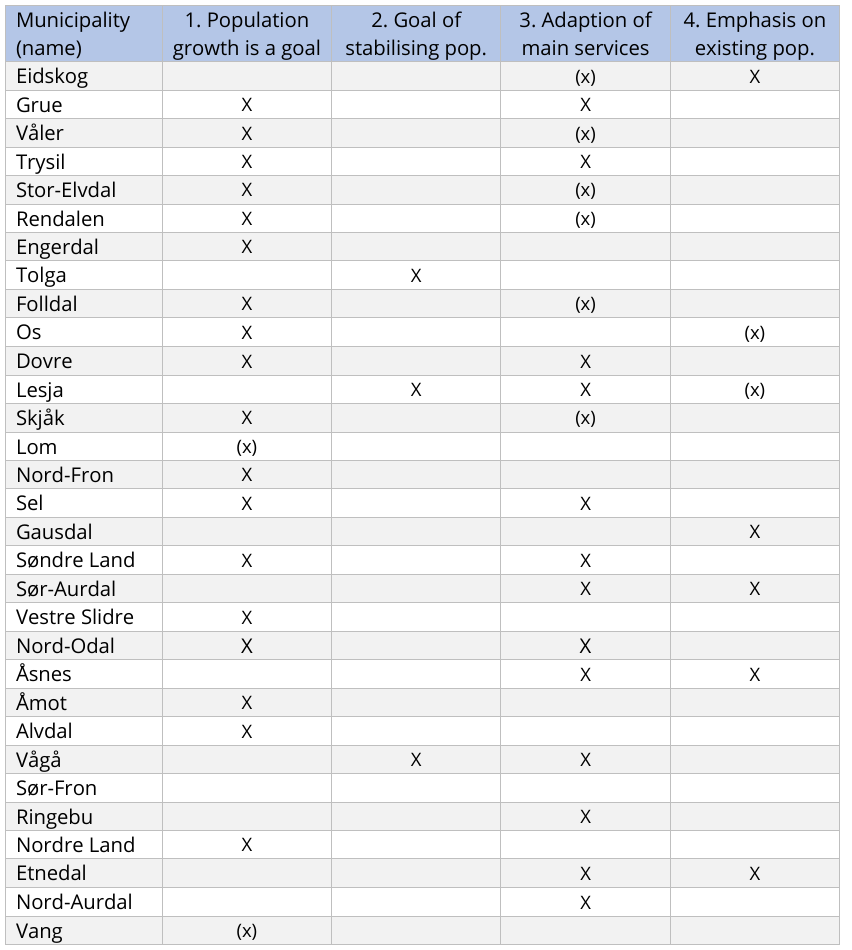
Table 2. How planning strategies and municipal plans for the 31 municipalities in Innlandet relates to current and future demographic